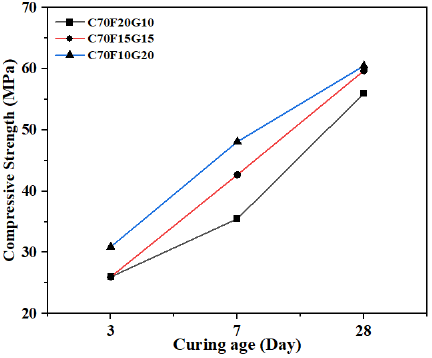
Figure 7. Group GGBS Compressive Strength.